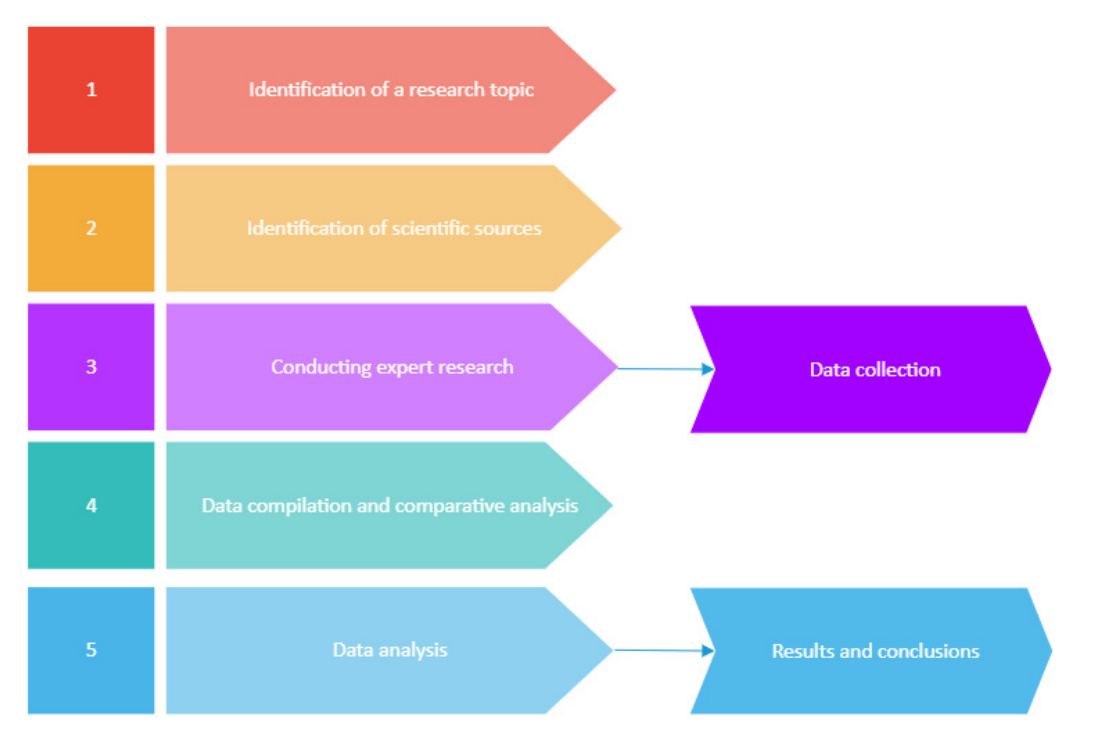
Figure 2. Research method process.